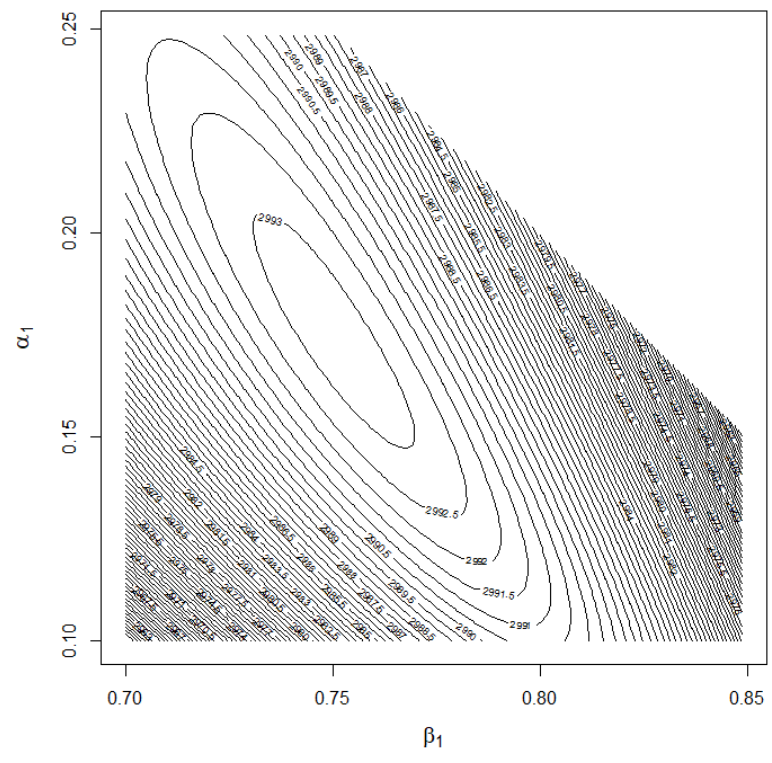
Figure 1: Constrained